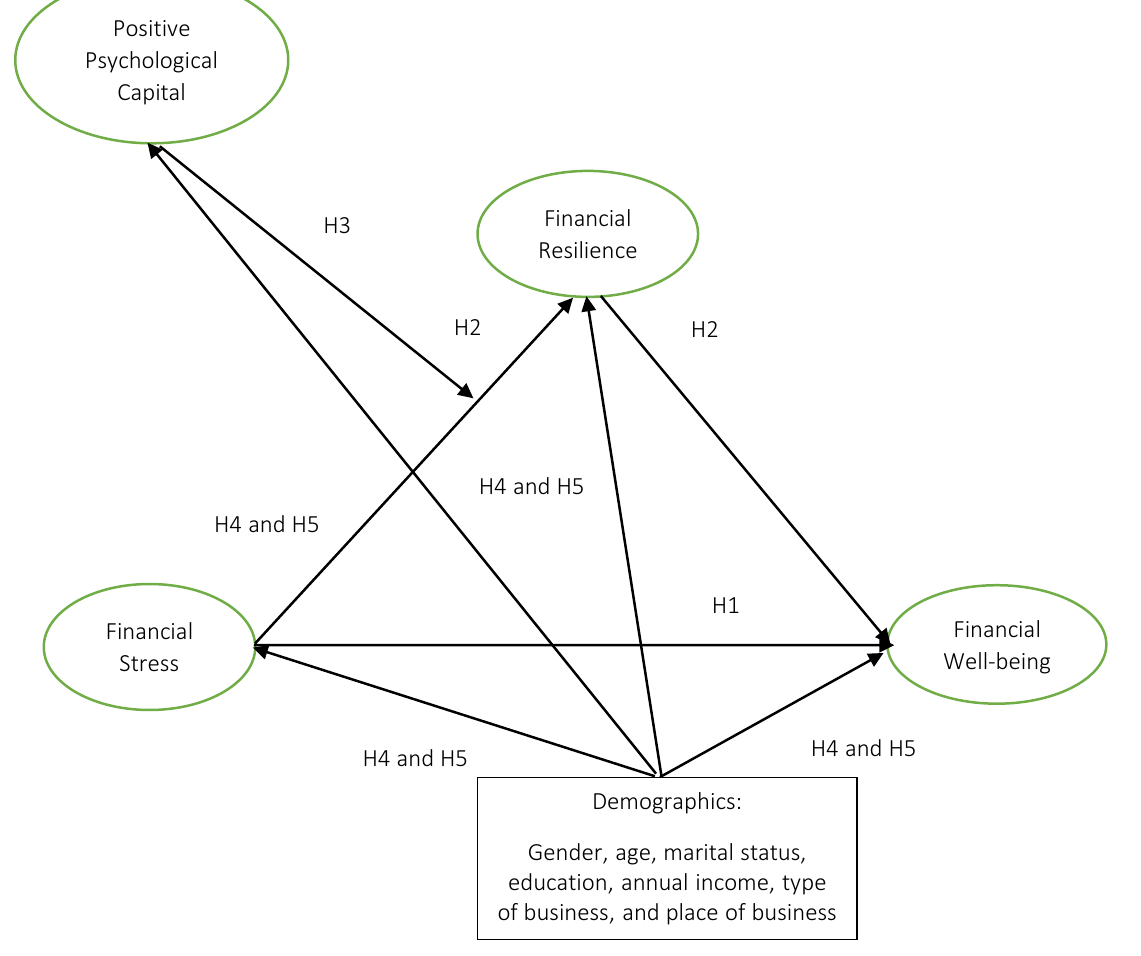
Figure 1. Research